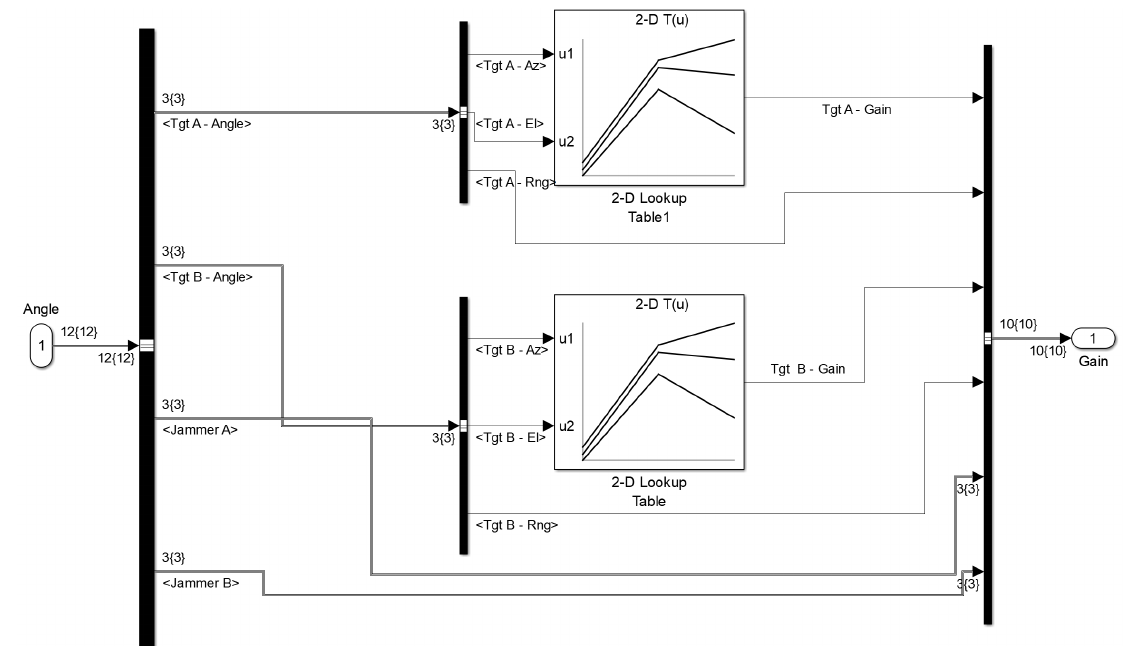
Figure 12. The antenna gain subsystem is implemented four times to replicate the four beams of the monopulse tracking system. In each case, as shown here, it takes the received azimuth and elevation for a signal and calculates the gain in that